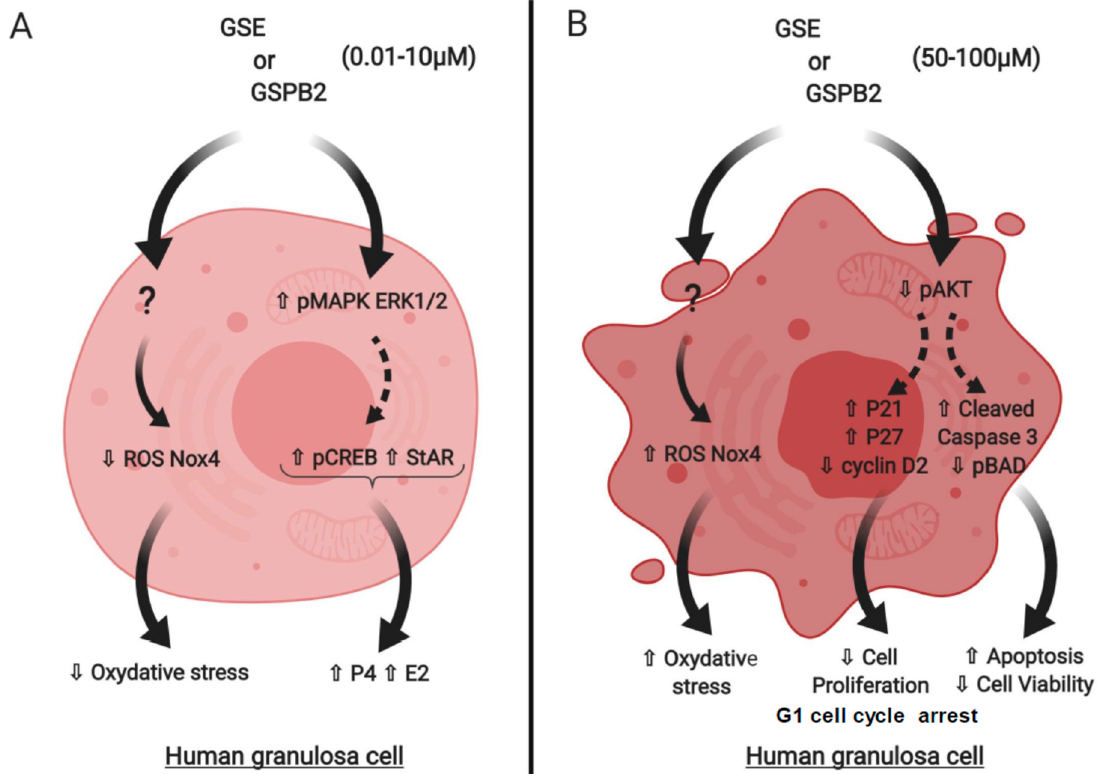
Figure 10. Schema representative of the effects of GSE and GSPB2 at different concentrations, ( A ) 0.01 to 10 µ g / mL and ( B ) 50 to 100 µ g / mL, on cell proliferation and viability, oxidative stress, steroidogenesis, and cell signaling in human granulosa cells. The question mark means that we don’t know the molecular mechanisms through GSE and GSPB2 bind to the cells. Dotted arrows suggest that an increase in MAPK ERK1 / 2 phosphorylation could explain an increase in CREB phosphorylation and StAR protein levels. Moreover, a decrease in Akt phosphorylation could induce an increase in p21, p27 and cleaved caspase 3 levels whereas it could decrease cyclin D2 protein and BAD phosphorylation levels.